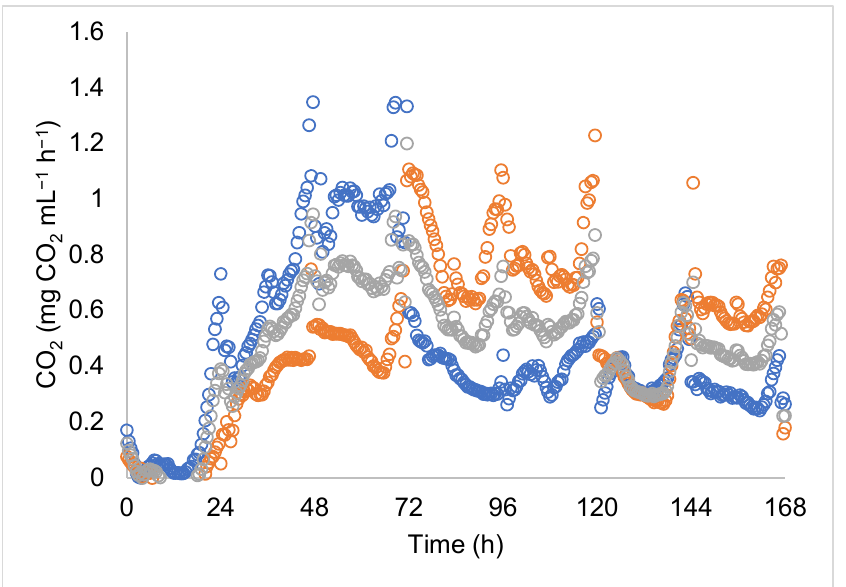
Figure 2. Evolution of CO 2 production during fermentation of Beauveria bassiana PQ2 for the production of aerial conidia and oosporein. The different colors of open circles are the repetitions. Table 2. Kinetic parameters of Beauveria bassiana PQ2 under biofilm bioreactor conditions.